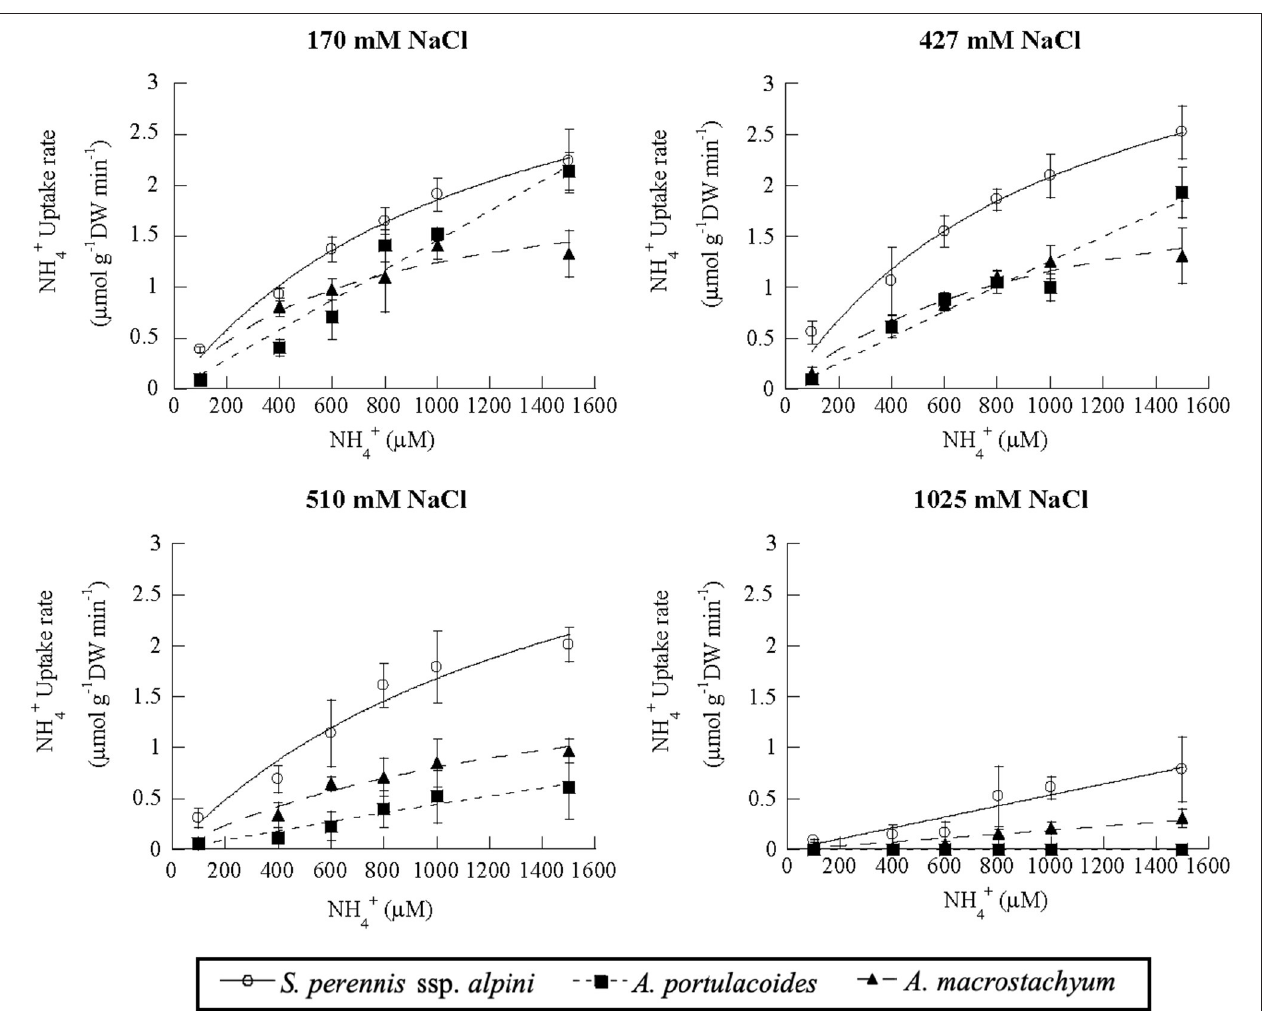
FIGURE 6 | Uptake kinetics of ammonium in S. perennis ssp. alpini, A. portulacoides and A. macrostachyum at different salinities (170, 427, 510, and 1,025mM NaCl). Bars represent standard deviations ( n = 4).